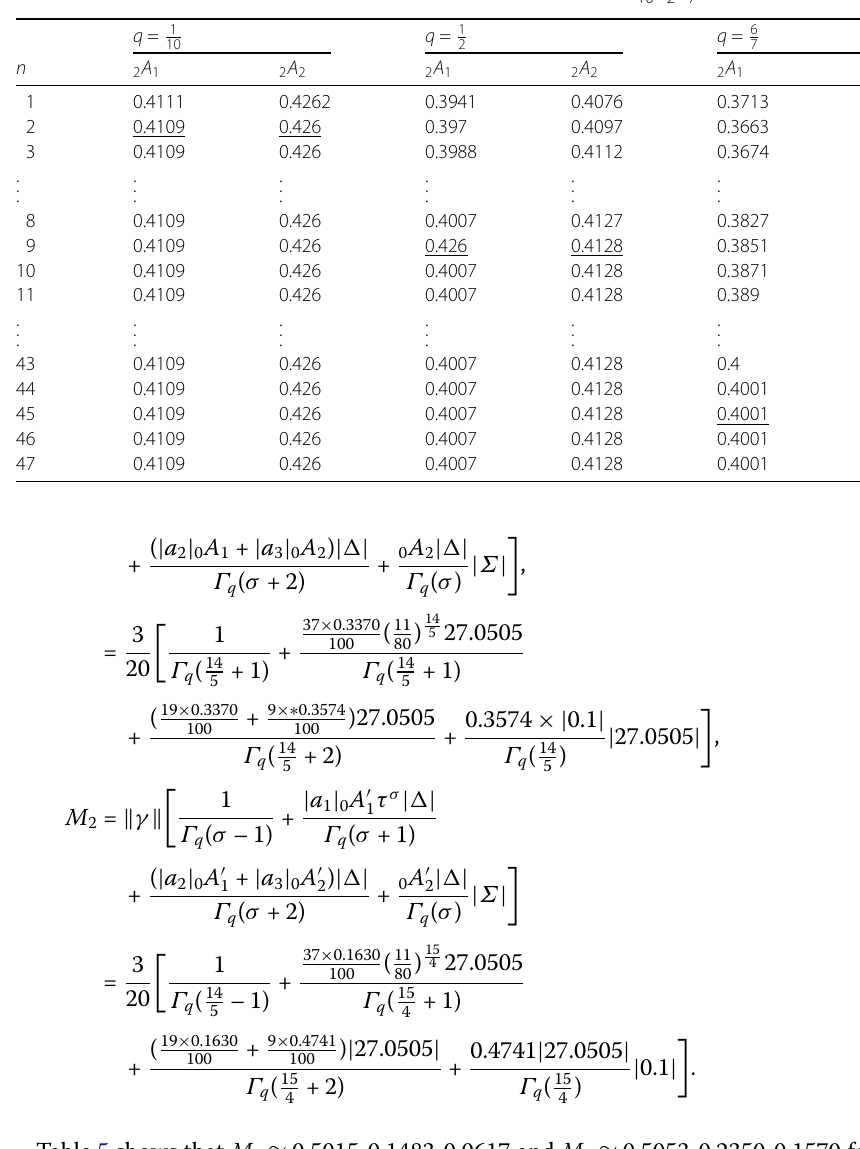
Table 2 Some numerical results for 2 A 1 and 2 A 2 in Example 1 for q = 1